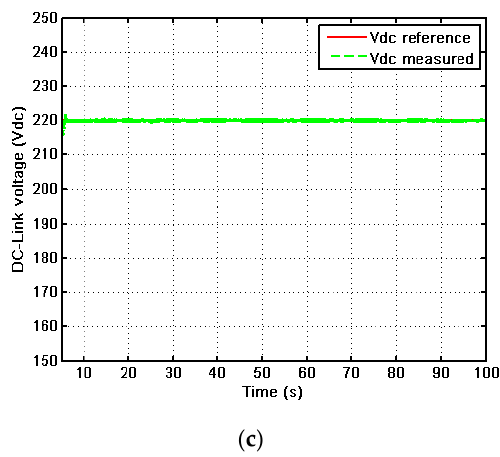
Figure 11. Control and estimation responses under random ramp wind speed profile and constant load: ( a ) Speed estimation and tracking; ( b ) power responses; ( c ) DC-link voltage regulation.